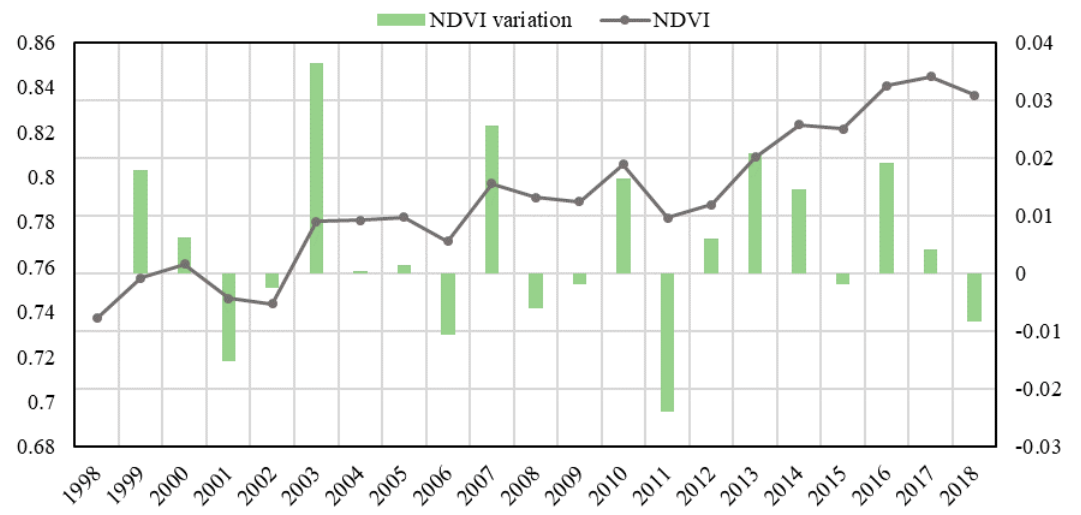
Figure 4. Areal mean change of annual NDVI from 1998 to 2018.